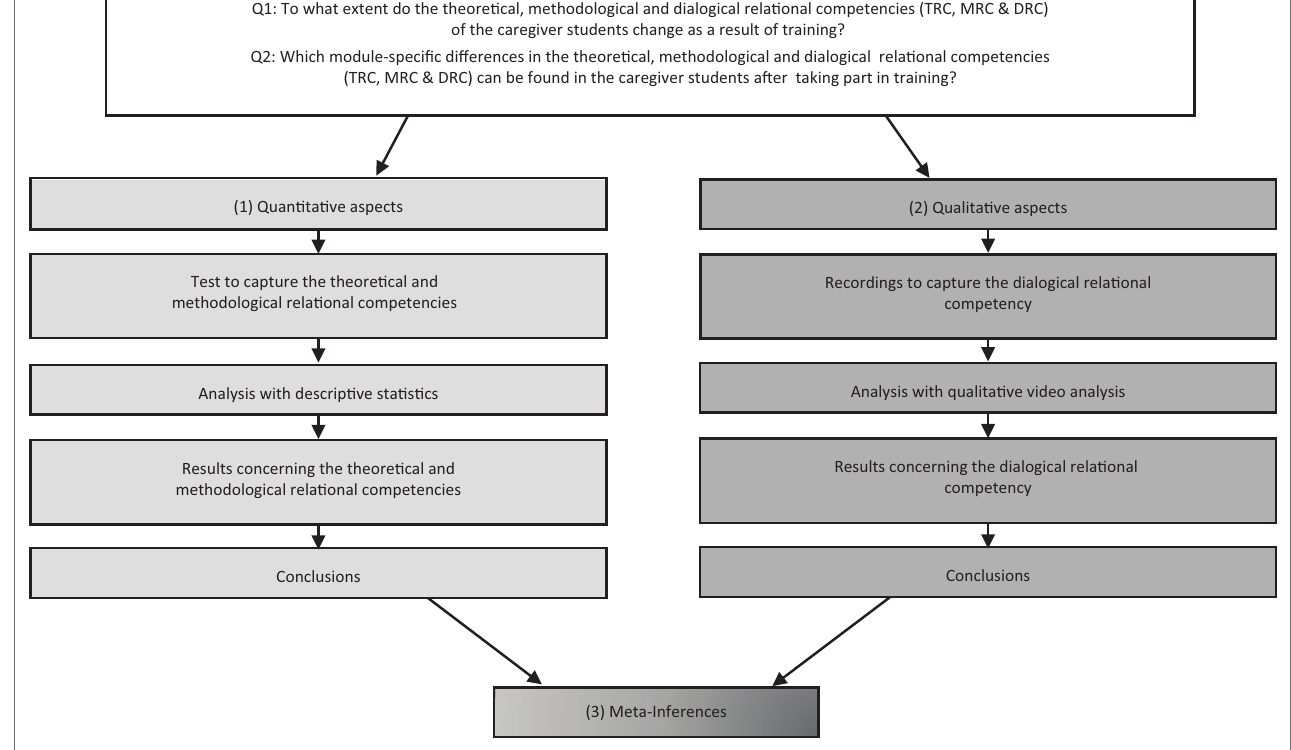
FIGURE 4: Detailed schema of the convergent design.